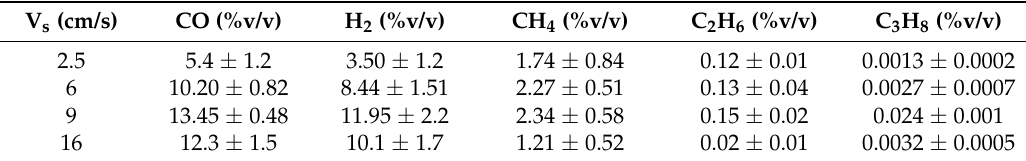
Table 3. Gas composition with superficial velocity.